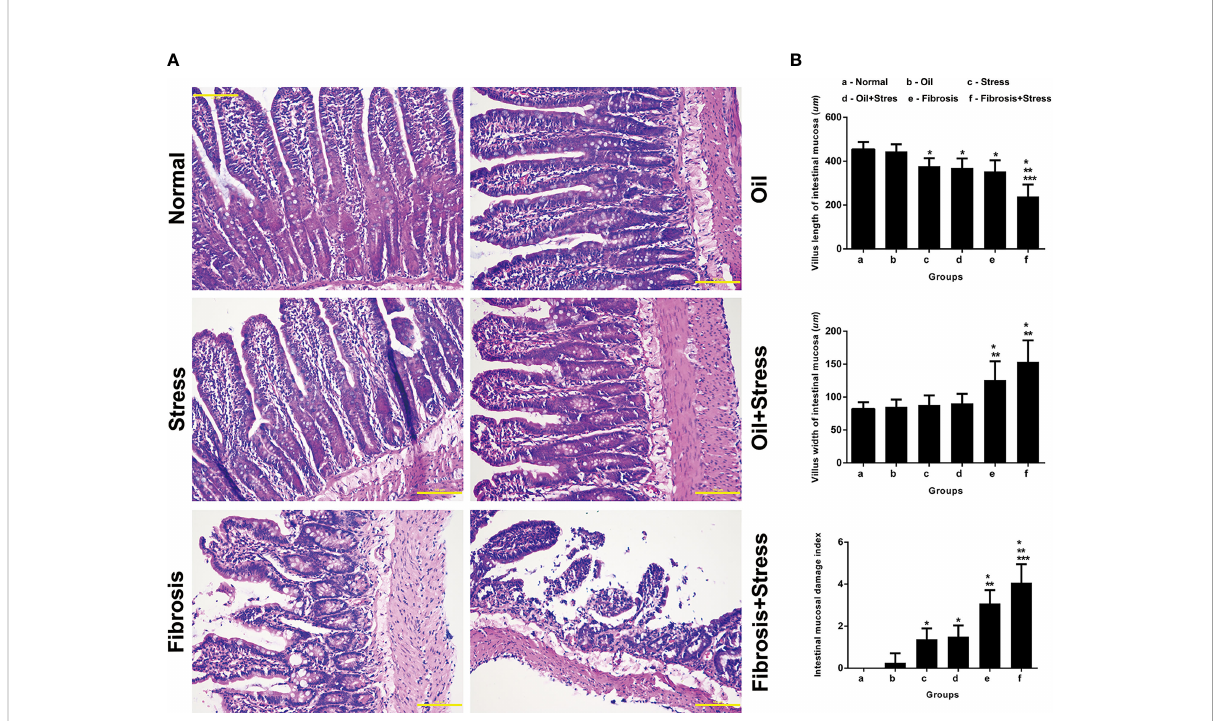
FIGURE 3 Mucosal lesions of intestinal tissue in rats. (A) HE staining of intestinal tissue. Scale bar: 100 um. (B) Quanti fi cation of mucosal lesions in intestinal tissue. (up) Villus length of intestinal mucosa. (middle) Villus width of intestinal mucosa. (down) Intestinal mucosal damage index. Data are shown as means ± SD. * p < 0.05 vs. normal group and oil groups; ** p < 0.01 vs. stress group and oil+stree groups; *** p < 0.001 vs. fi brosis group.